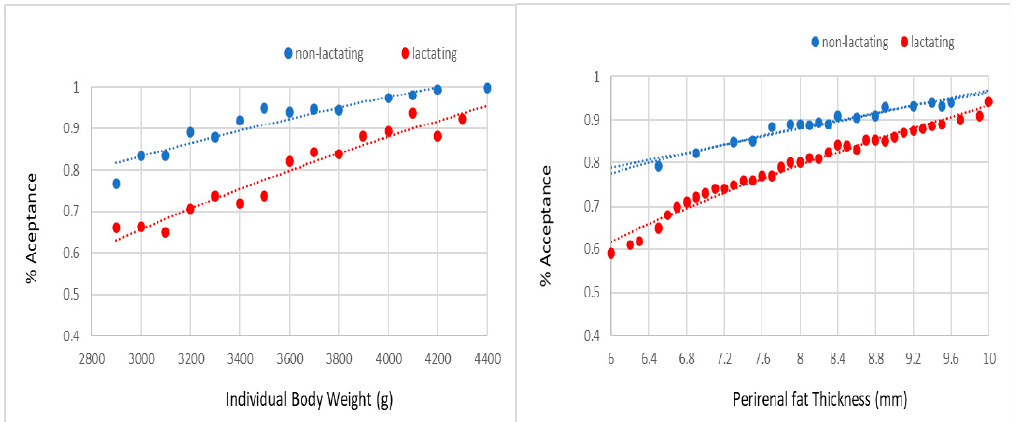
Figure 2. Probability of acceptance of the male at mating on individual body weight and perirenal fat thickness at 10 day after delivery (i.e., third mating in lactating and non-lactating does).